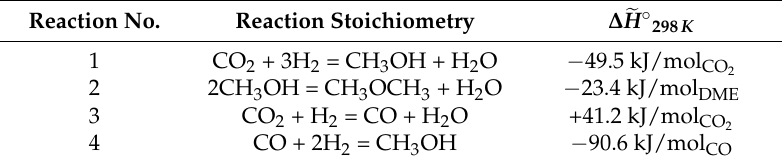
Table 2. List of reactions involved in one-pot CO 2 hydrogenation to